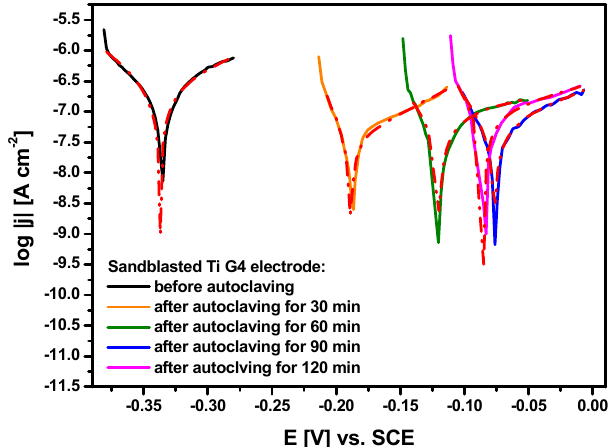
Figure 8. Polarization curves near the E OC obtained for the sandblasted Ti G4 electrode before and after autoclaving in ASS at 37 °C. Experimental data are marked as continuous lines and fitted data using the Tafel extrapolation as red dash dotted lines. Table 8. Corrosion resistance parameters determined based on the Tafel extrapolation method of the polarization curves for the Ti G4 electrodes before and after autoclaving immersed in ASS at 37 °C (see Figure 8).